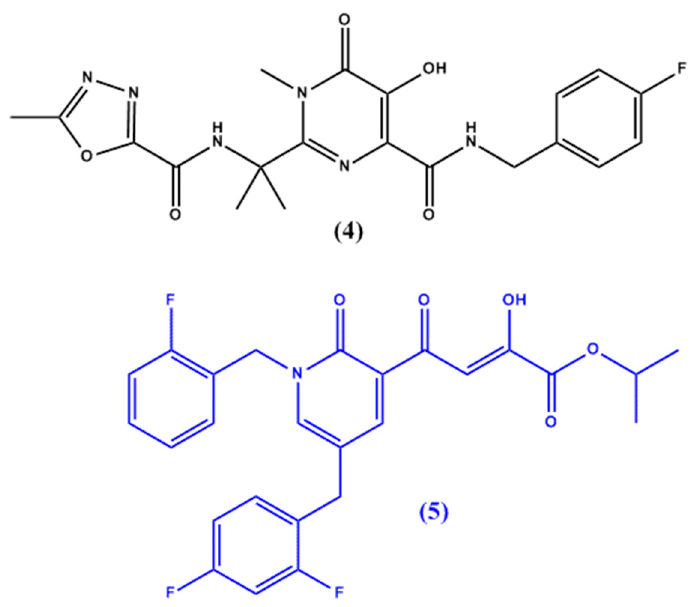
Figure 2. Chemical structures of raltegravir ( 4 ) and novel HIV integrase inhibitor 5 .